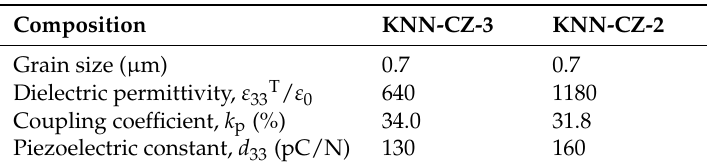
Table 7. Piezoelectric properties of KNN-CZ-3 single-layer disk sample vs. those of KNN-CZ-2 sample (measured temperature: 25 °C).